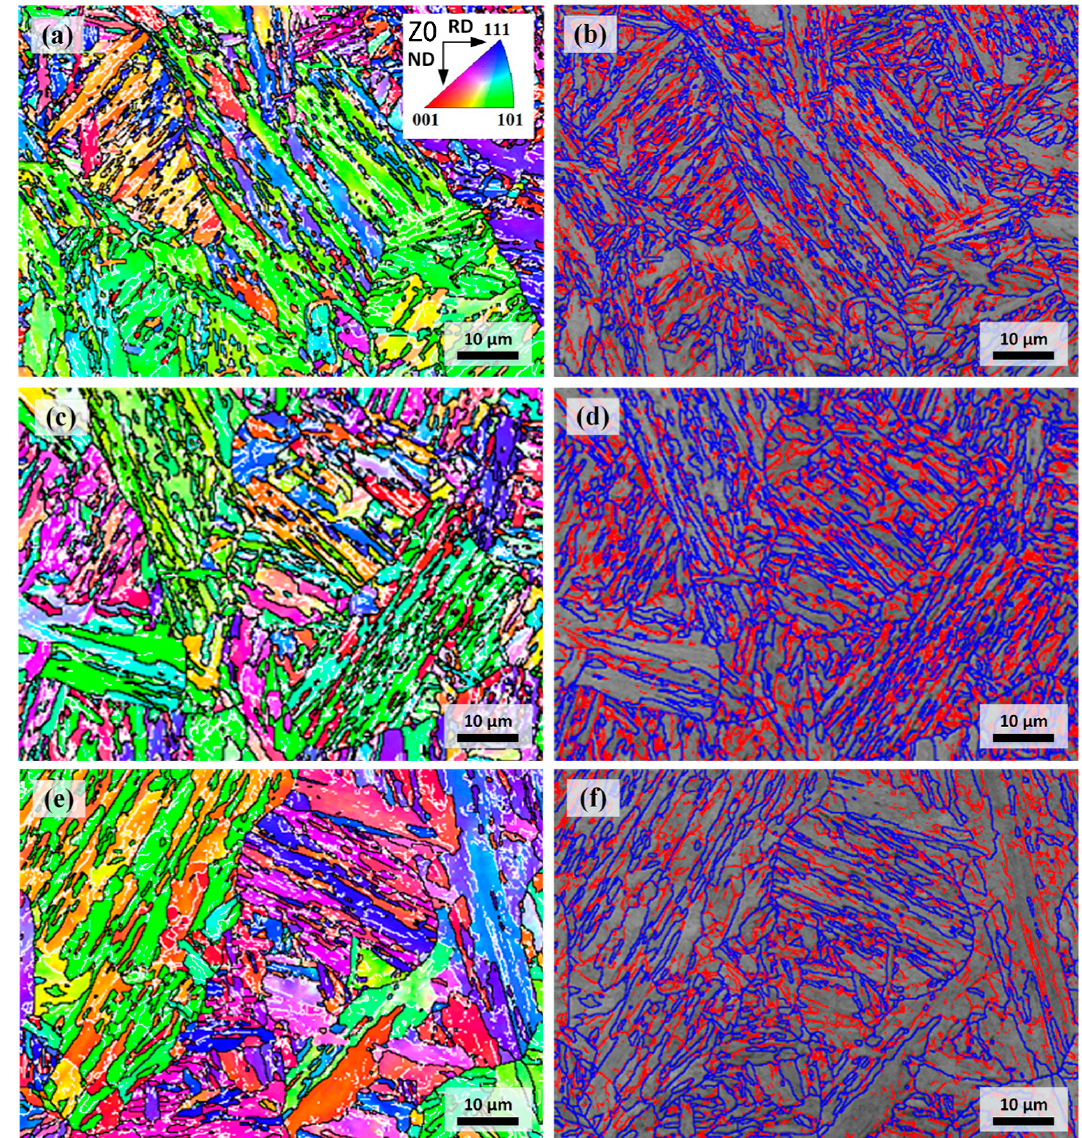
Figure 2. Inverse pole figure (IPF) maps and grain boundary misorientation distributions of the varied positions. ( a , b ) sub-surface, ( c , d ) t /4, ( e , f ) t /2.